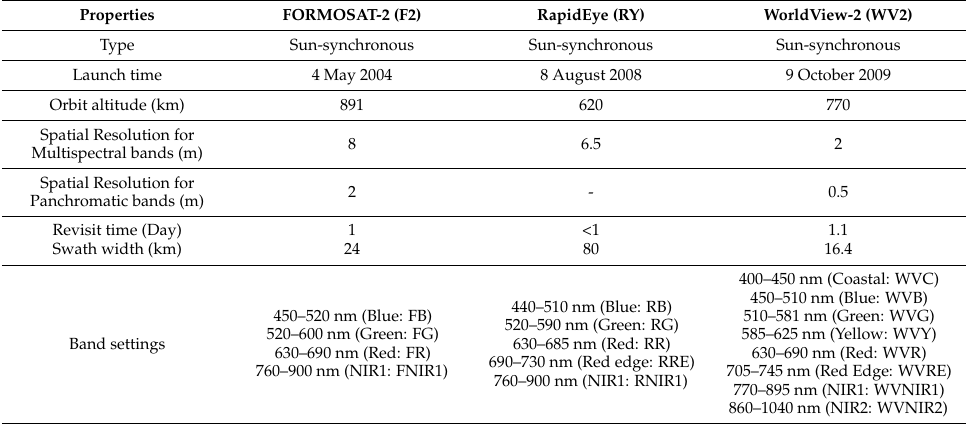
Table 2. The properties of the FORMOSAT-2, RapidEye, and WorldView-2 satellite